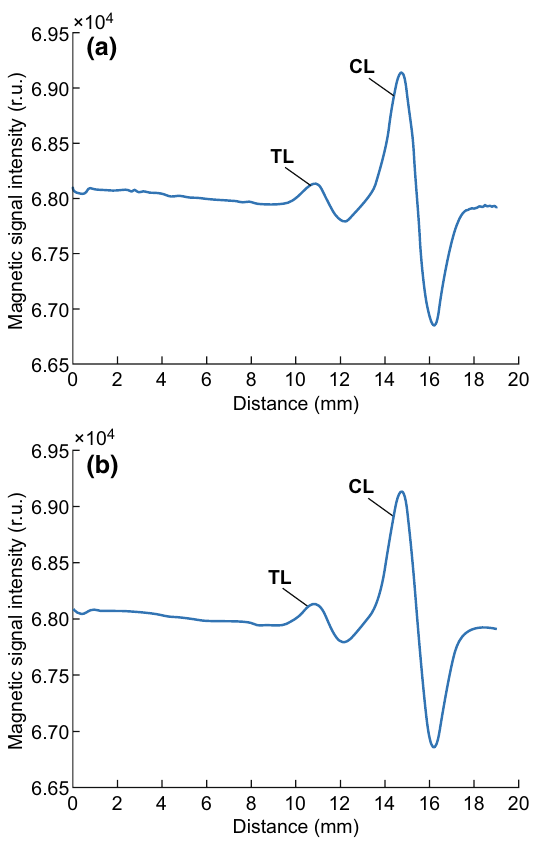
Fig. 6 a Waveform of raw detection data. b Filtered